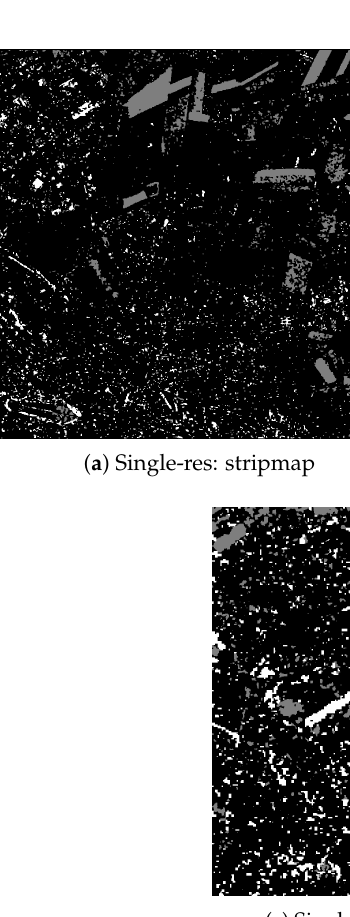
Figure 7. Change maps obtained by applying a single-resolution formulation of the proposed method to the stripmap ( a ) and polarimetric ( b ) temporal pairs, and by replacing the virtual features by the log-ratios of the polarimetric channels upsampled to the stripmap lattice ( c ).